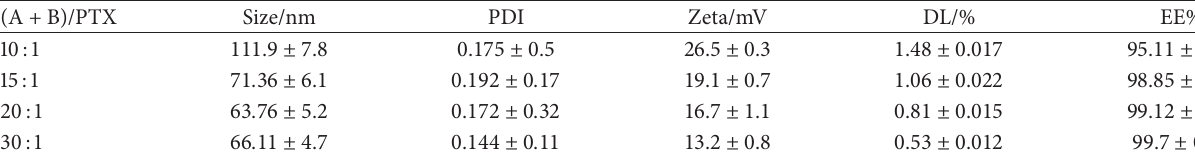
Table 2: Data of PTX liposome when mass ratio of A/B is 2 :8.